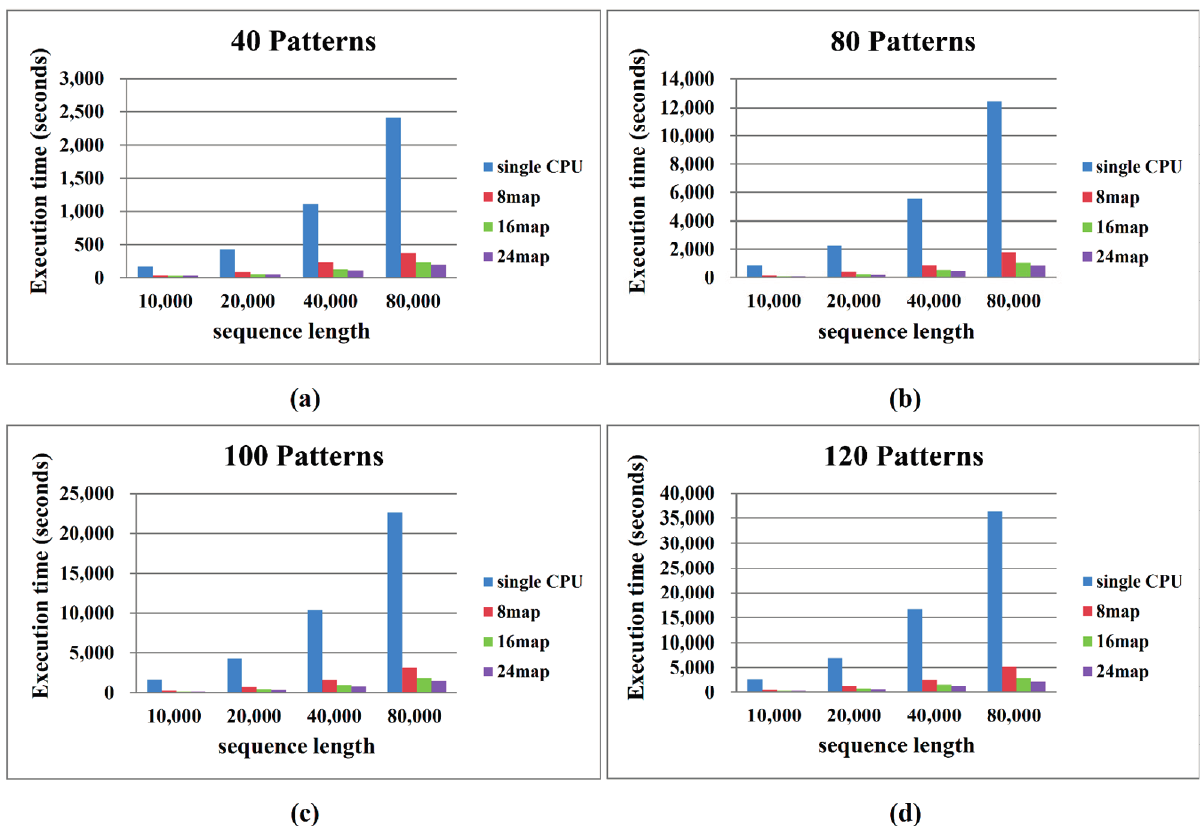
Figure 5. Performance comparison between sequential and MapReduce haplotype block selection (block size = 500 bp). ( a ) Number of Patterns is 40; ( b ) Number of Patterns is 80; ( c ) Number of Patterns is 100 and ( d ) Number of Patterns is 120.